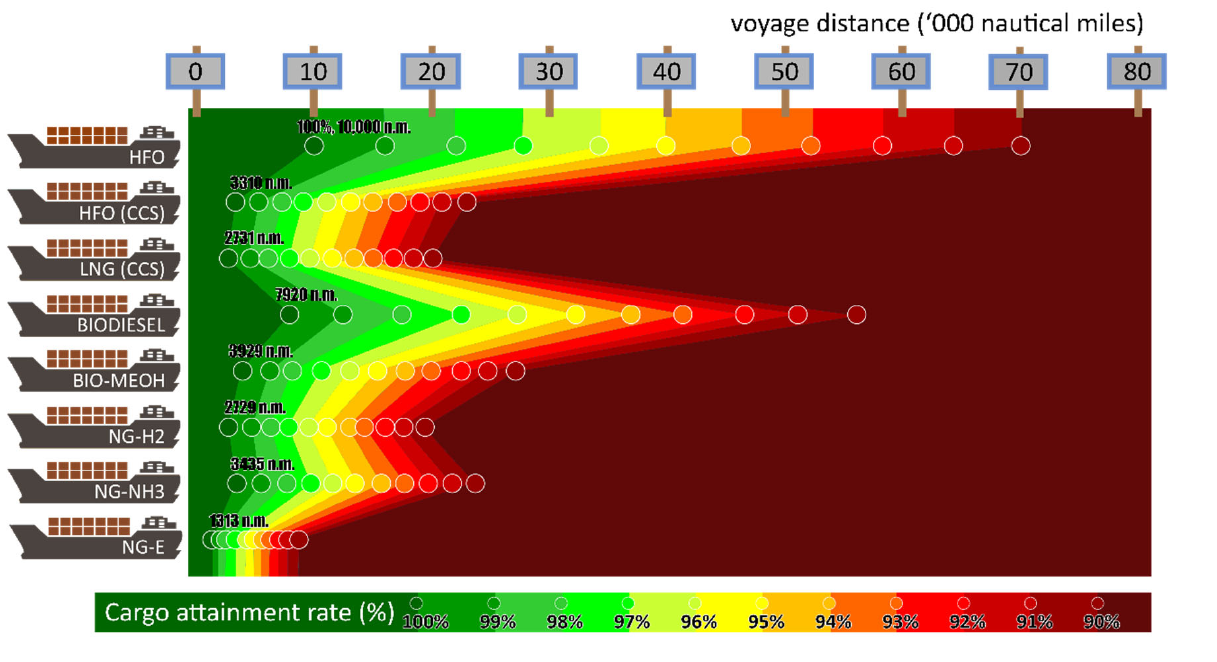
Figure 12. Scenarios ‐ based analysis for deep ‐ seagoing containership with voyage distance of 10,000 nm. 4. Discussion From a Well ‐ to ‐ Wake perspective, the results of Ref. [17] compared 22 different pathways of primary energy source, fuels, and propulsion systems. The comparison was made on the basis of work at the propeller, i.e., how much energy is needed and how much carbon is emitted on a lifecycle basis to deliver a given amount of work. However, more refined data may be needed by policy makers and ship operators to decide routes and decarbonization strategies, and such an effort was presented in this paper. Seven al ‐ ternative fuels have been selected regardless of the primary energy source and the anal ‐ ysis was done from a Tank ‐ to ‐ Wake perspective. The present results demonstrate that